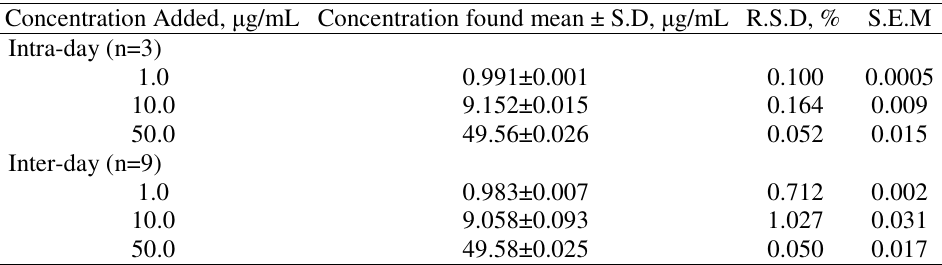
Table 7 . Precision of method for determination of venlafaxine hydrochloride (n=9; Three sets for 3d)